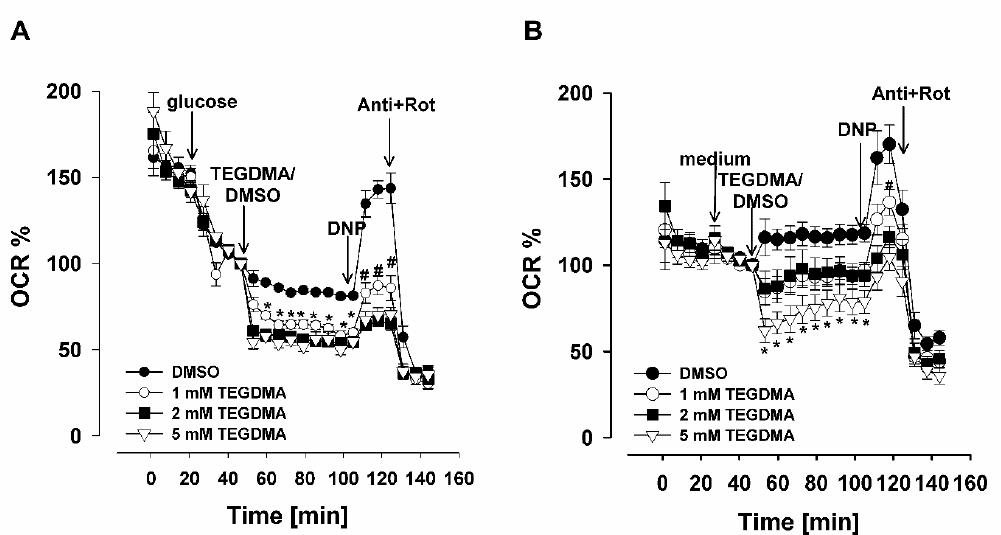
Figure 3. Relative oxygen consumption of dental pulp stem cells in the presence ( A ) and absence of glucose ( B ). Glucose (10 mM; A) or XF medium ( B ), TEGDMA (1; 2 or 5 mM) or DMSO,